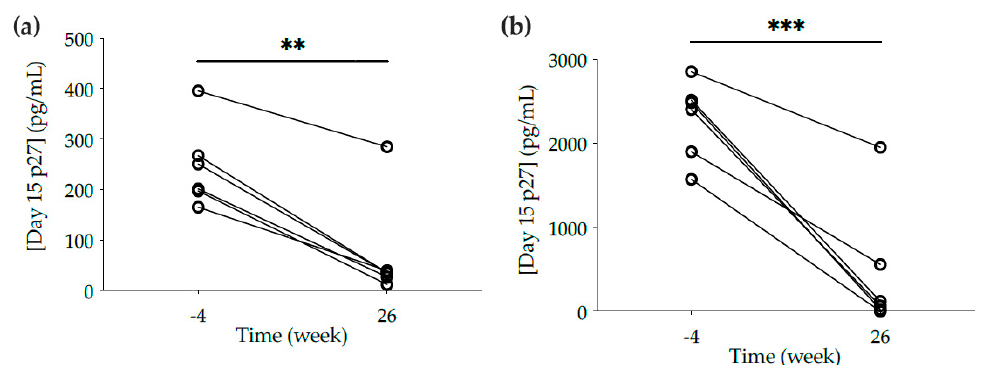
Figure 2. Ex vivo challenge of mucosal explants with SHIV BaL . ( a ) Cervical and ( b ) rectal explants cut from biopsies and tissue resected at necropsy were obtained at weeks -4 and 26, respectively. Explants were incubated with SHIV BaL for 2 h, washed four times in PBS, and cultured on gel foam for 15 days. The levels of p27 in the culture supernatants were measured by ELISA at day 15. The data are the means of at least duplicates for each macaque. Lines connect the data from the two time points for each animal. Statistical significance: ** p ≤ 0.01, *** p ≤ 0.001.